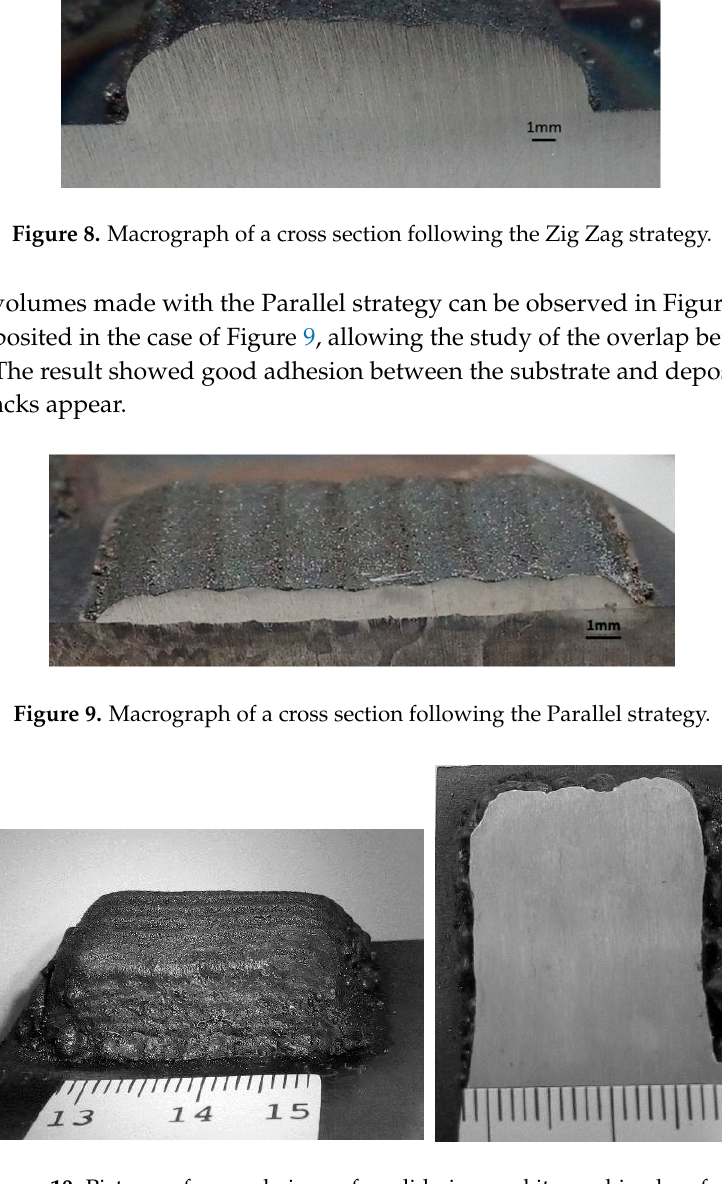
Figure 7. Macrograph of a cross section following the Zig Zag strategy.